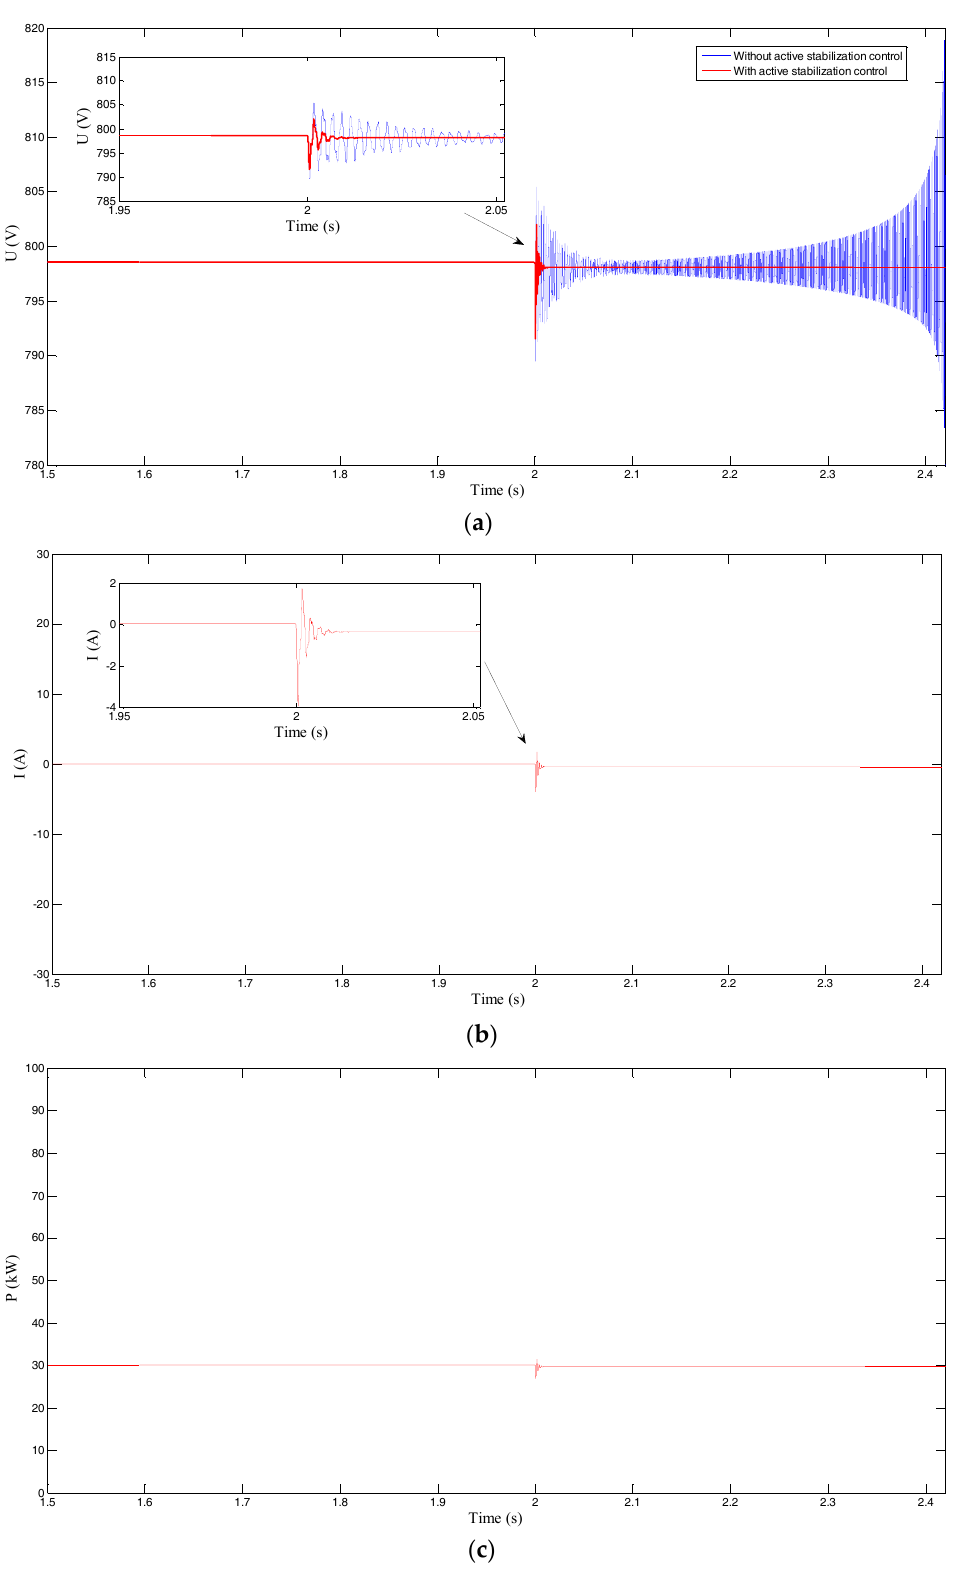
Figure 8. Simulation waveform by changing P s1 = 50 kW to P s1 = 90 kW at t = 2 s: ( a ) U dc ; ( b ) i dc,active ; and ( c ) P dc .